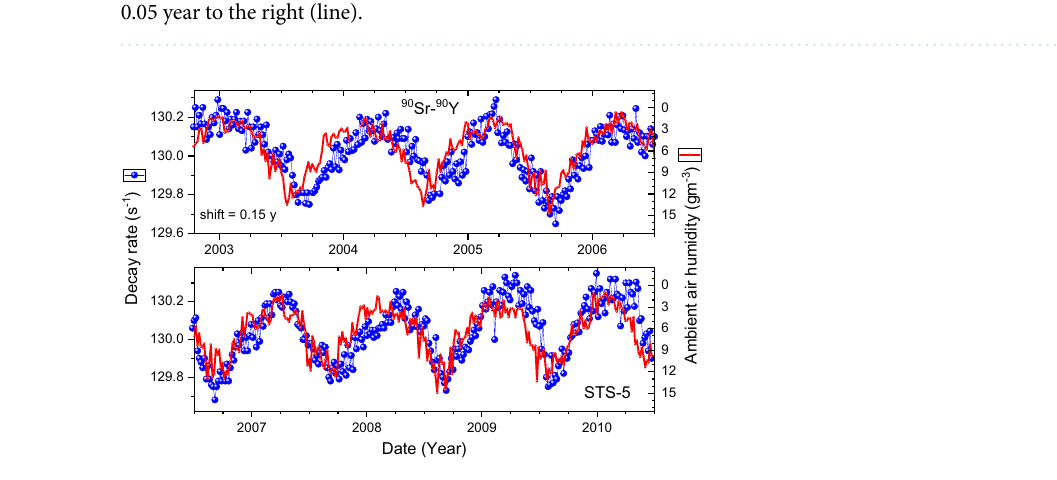
Figure 6. Decay-corrected count rates of 90 Sr/ 90 Y beta decay obtained with the STS-5 G–M counter (dots), compared to absolute humidity in Moscow calculated from weather data shifted in time by 0.15 year to the right